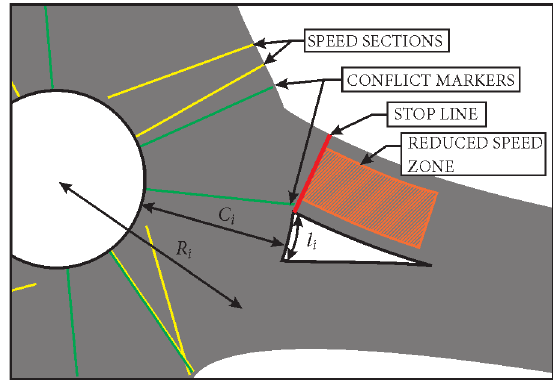
Fig. 2. VISSIM screenshot of the modelled roundabout